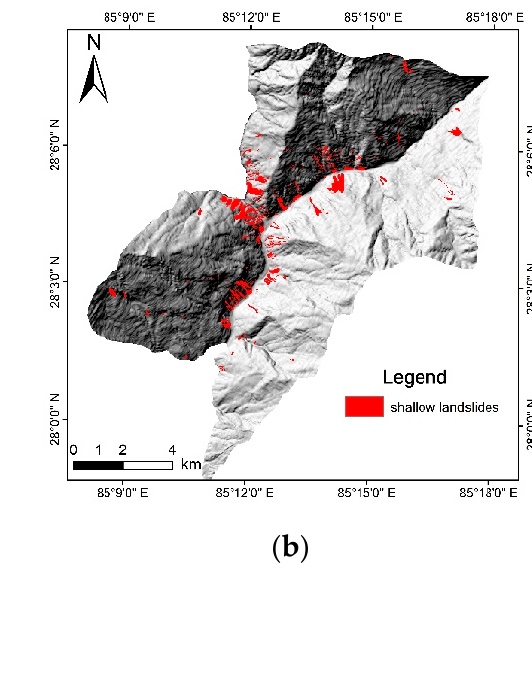
Figure 3. The rainfall data used in the physically based model: ( a ) daily rainfall, ( b ) antecedent rainfall. The DEM data were derived from the 1:50,000 topographic map (Survey Department Government of Nepal). The landslide inventory and land cover map were interpreted from remote sensing images and calibrated in the field investigation. Soil depth was simulated based on Equation (8). where SD is the simulated soil depth (m), a–f are calibration constants (-), d coast is the distance to the nearest coast (m), d channel is the distance to channels, S is the slope index (-), C is the profile curvature (m-1), and W is the wetness index. The base maps used in the model are shown in Figure 4.